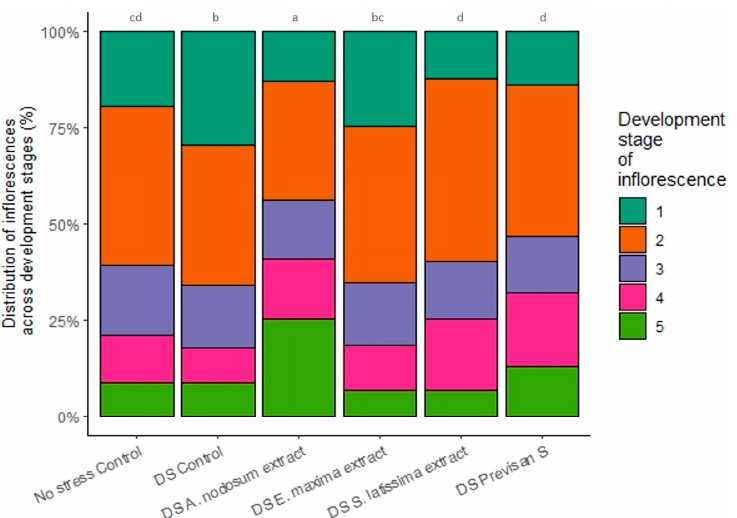
Figure 6. E ff ect of the drying cycles without (DS Control) and with biostimulants treatments on fl ower development of Hydrangea paniculata compared with optimal irrigation (No stress Control).